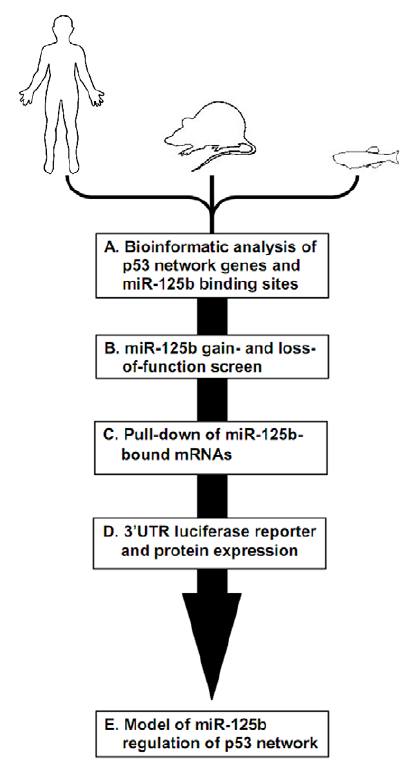
Figure 1. Identifying miR-125b targets in the p53 network of vertebrates. Schematic of experimental design and workflow. (A) Bioinformatic analysis was performed on p53 network genes listed in the Ingenuity Pathways Analysis database and p53 Knowledgebase, and miR-125b binding sites predicted by the TargetScan and MicroCosm databases. (B) p53 network genes were screened for miR-125b targets by using gain- (GOF) and loss-of-function (LOF) of miR-125b in human cells, mouse cells and zebrafish embryos, as indicated by effects on gene expression using qRT-PCR. (C) p53 network genes that were positive in either the GOF or LOF screen were assayed for direct binding to miR-125b using a biotinylated microRNA pull-down method. (D) p53 network genes that were also positive in the miR-125b pull-down were finally validated as miR-125b targets by 3 9 UTR luciferase reporter assays and Western blots for protein expression. (E) A model of how miR-125b regulates the p53 network across vertebrates was constructed using our combined datasets for human, mouse and zebrafish cells.